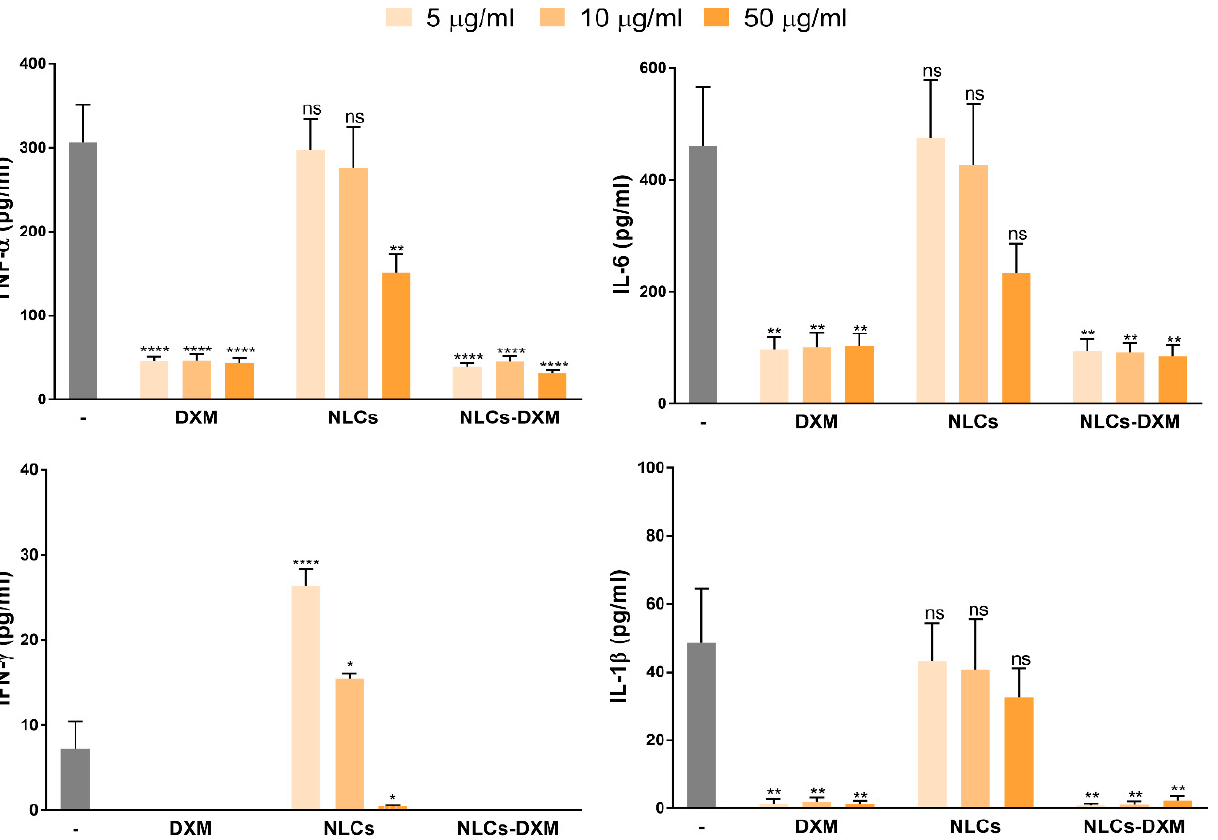
Figure 7. NLC-derived DXM prevents LPS-induced NPC activation. TNF- α , IL-6, IFN- γ and IL-1 β levels of DXM-treated of NPCs cultures were monitored. NPCs were incubated with NLC formulations (5, 10 and 50 µ g/mL), followed by LPS (100 ng/mL) application. On the next day, supernatants were subjected to cytokine analysis. Data denote the means ± SEM obtained in 3 independent experiments. Significantly different from control (LPS only): no significant difference (ns); * p < 0.05; ** p < 0.01; **** p < 0.0001 (Two-way ANOVA, Dunnett’s multiple comparisons test).